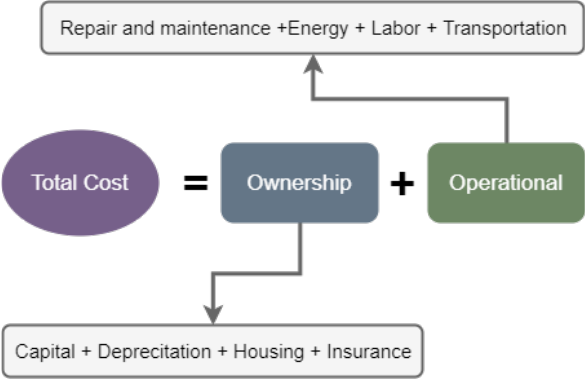
Figure 1. Cost elements considered in the economic assessment.